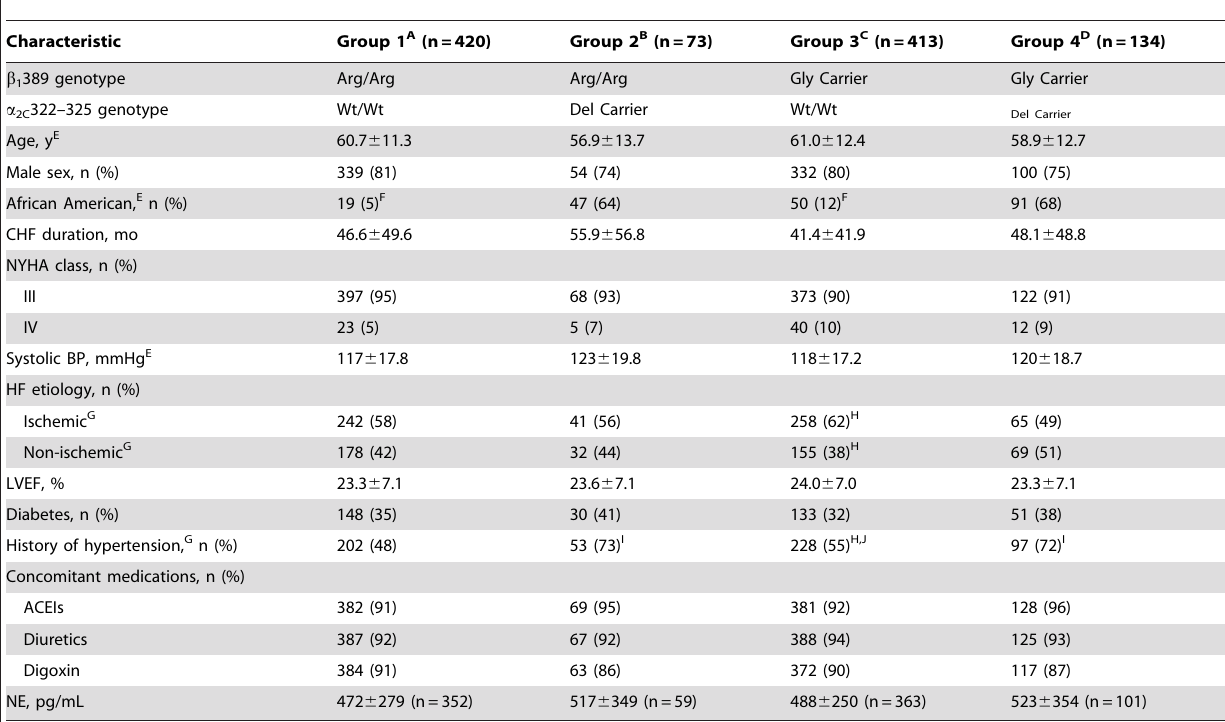
Table 1. Baseline characteristics by genotype combination